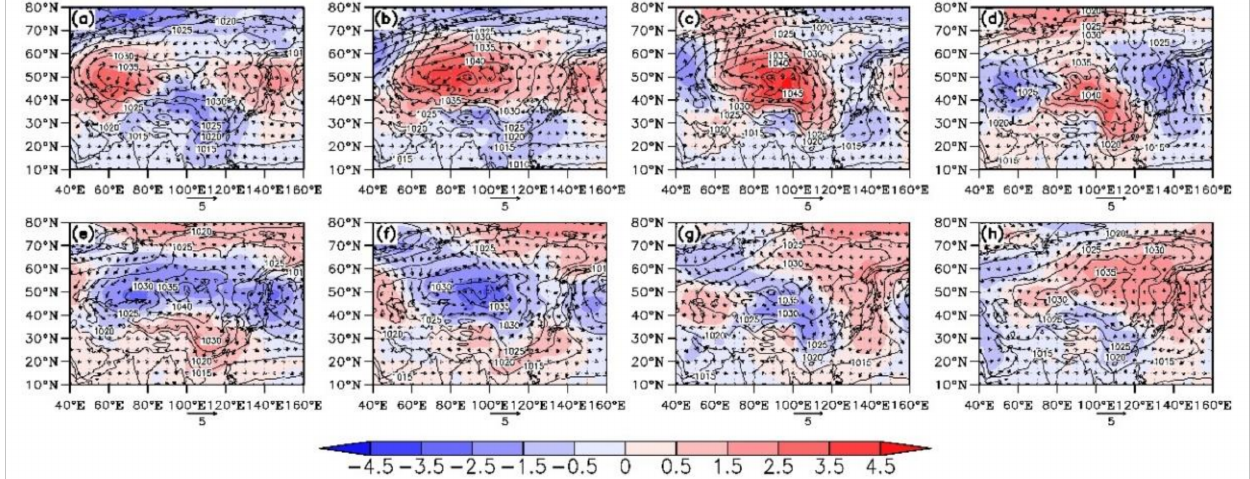
Figure 10. Composition of the 10–20 d filtered SLP field (shaded, unit: hPa), 850 hPa wind field (arrow, unit: m/s), and the unfiltered SLP field (contour, unit: hPa) 7 days before and after day 0 in WPECE (( a – h ): –7 d, –5 d, –3 d, –1 d, 1 d, 3 d, 5 d, 7